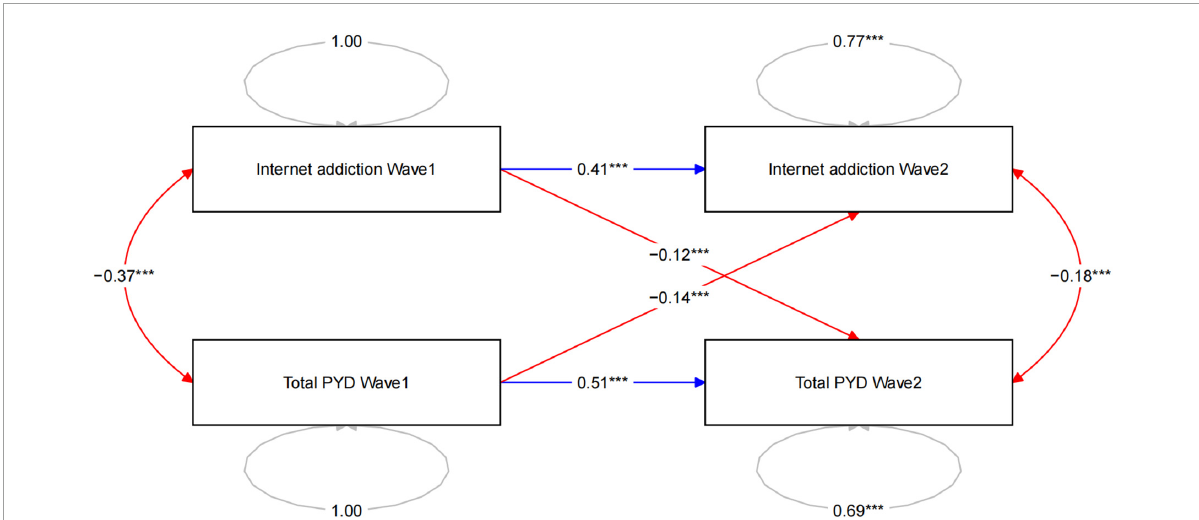
FIGURE1 Cross-lagged panel model between positive youth development (PYD) qualities and the Internet addiction. Internet addiction Wave 1: Internet addiction scores before the COVID-19 lockdown; Internet addiction Wave 2: Internet addiction scores during the COVID-19 lockdown; Total PYD Wave 1: Total PYD score before the COVID-19 lockdown; Total PYD Wave 2: Total PYD score during the COVID-19 lockdown. The two-way arrow indicates the result of correlation analysis; the one-way arrow indicates the result of path analysis; the correlation coefficient and regression coefficient are a standardized estimations. *** p <